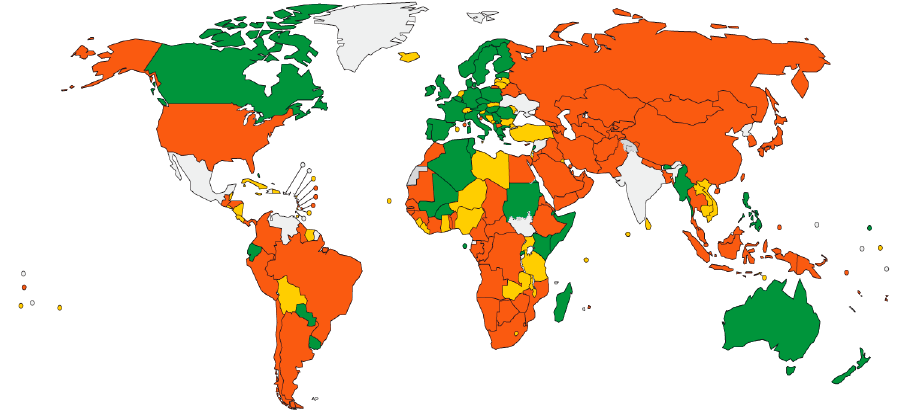
Figure 2. Urban speed limits by